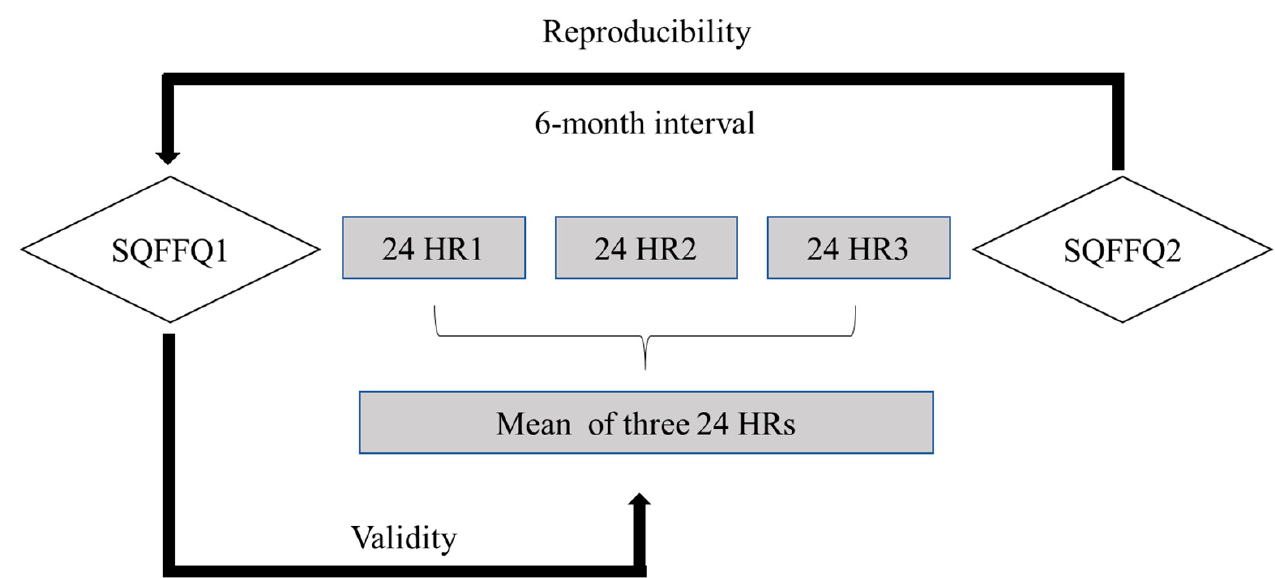
Figure 1. Study design and schedule used in this study. A 22 food groups semi-quantitative food frequency questionnaire (SQFFQ) was administrated at the baseline (SQFFQ1) and 6 months later (SQFFQ2) to vegetarians and omnivores by trained interviewers with a face-to-face approach. The 24 h dietary recalls (24 HRs) for three consecutive days (including two weekdays and one weekend day) were performed by participants between SQFFQ1 and SQFFQ2 to recall the items and portion sizes of all foods that they consumed from the last day (22:00) to the next day (22:00). The reproducibility was tested by comparing the results from two SQFFQs, and the validity was assessed by comparing the data obtained from the SQFFQ1 and the mean 24 HRs.